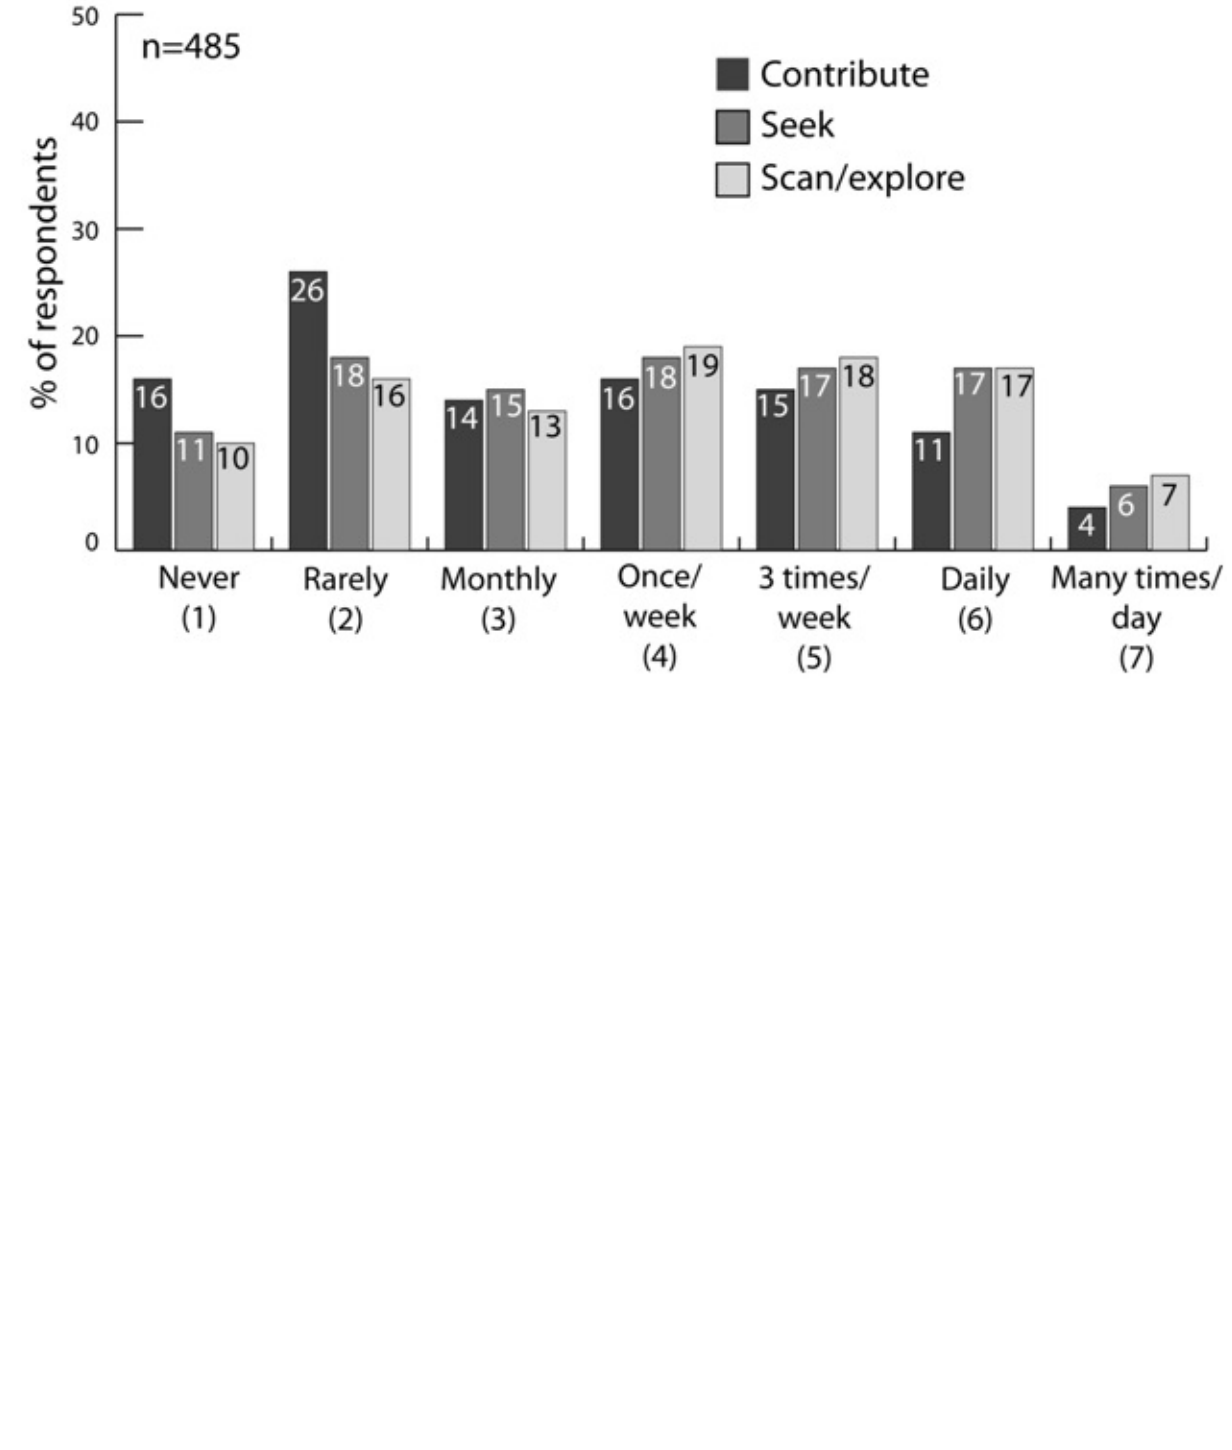
Figure 3. Physicians' frequency of using social media to contribute medical knowledge to other physicians, to seek specific information about a medical problem or situation, and to scan or explore medical knowledge for new